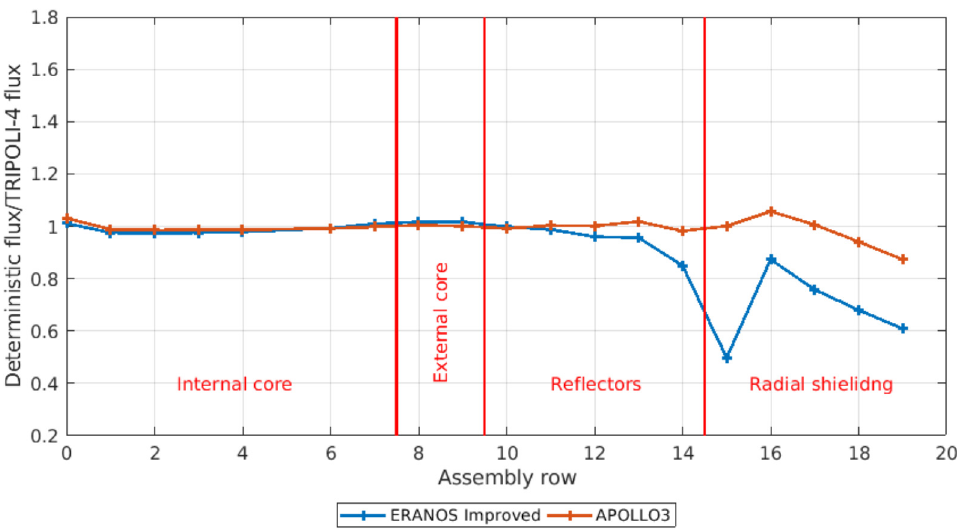
Fig. 15. Deterministic-stochastic comparison on the radial traverse of the ASTRID core.